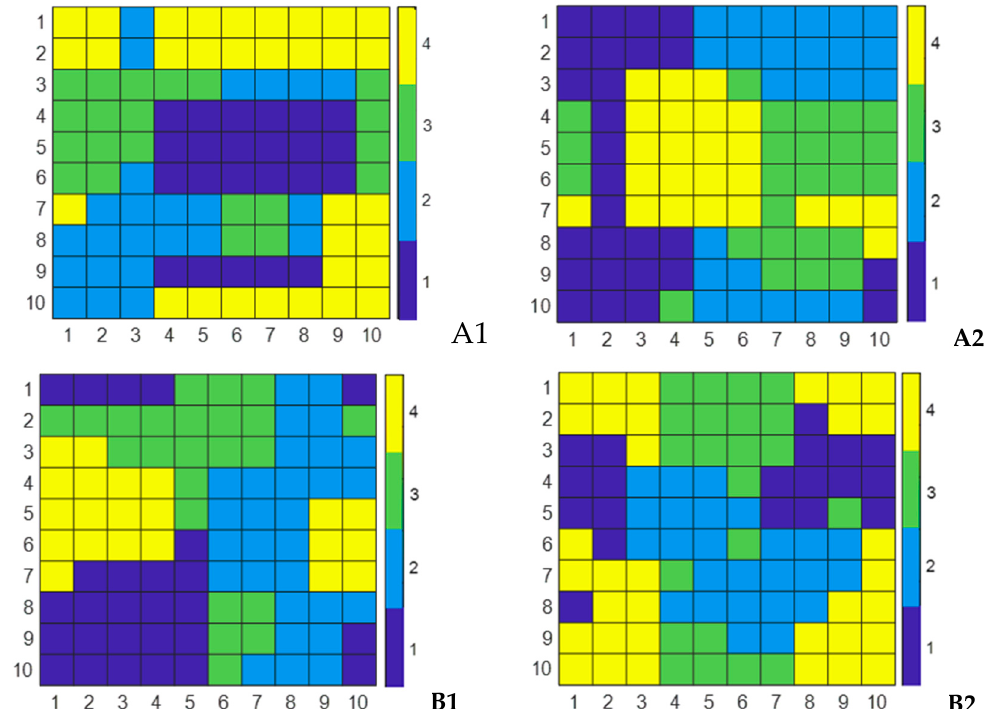
Figure 4. Neuron class assignments in the XY-F network’s class layer as it was trained before the outlier elimination for the EW features ( A1 and A2 ) and for the VI features ( B1 and B2 ). The axes represent the SOM grid (10 x 10 neurons). The index 1 denotes the results before the outlier elimination, while the index 2 denotes the respective results after the outlier elimination. Each pixel color represents one of the target classes (dark blue for class 1, light blue for class 2, green for class 3 and yellow for class 4).